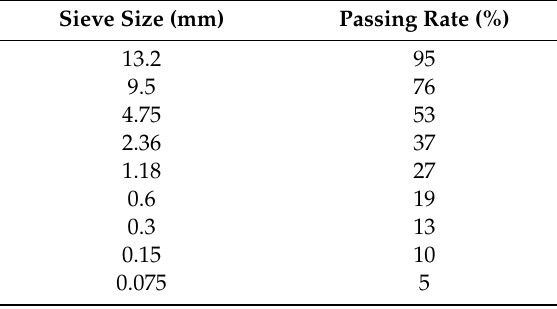
Table 1. Particle size distribution of aggregates.